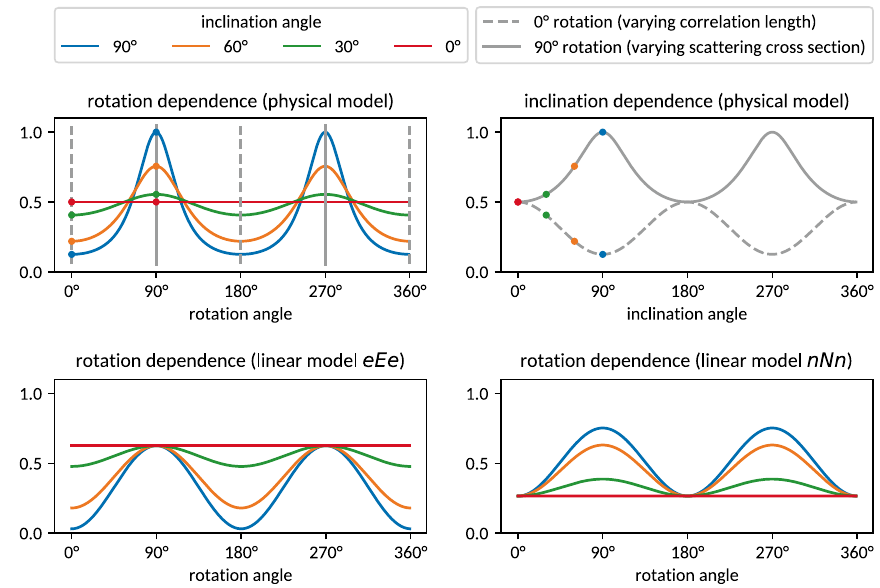
Figure 2. The different orientation dependencies of the physical model of dark-field anisotropy and the linear tensor models considered for reconstruction. Modeled is an elongated object inclined with respect to a rotational axis perpendicular to both the optical axis and the axis of interferometer sensitivity, cf. Fig. 1. The original signal (upper left) is generated according to Eq. (3) (with σ 3 /σ 1 1. The respective scales and offsets of the linear approximations (bottom row) emerge from the reconstruction